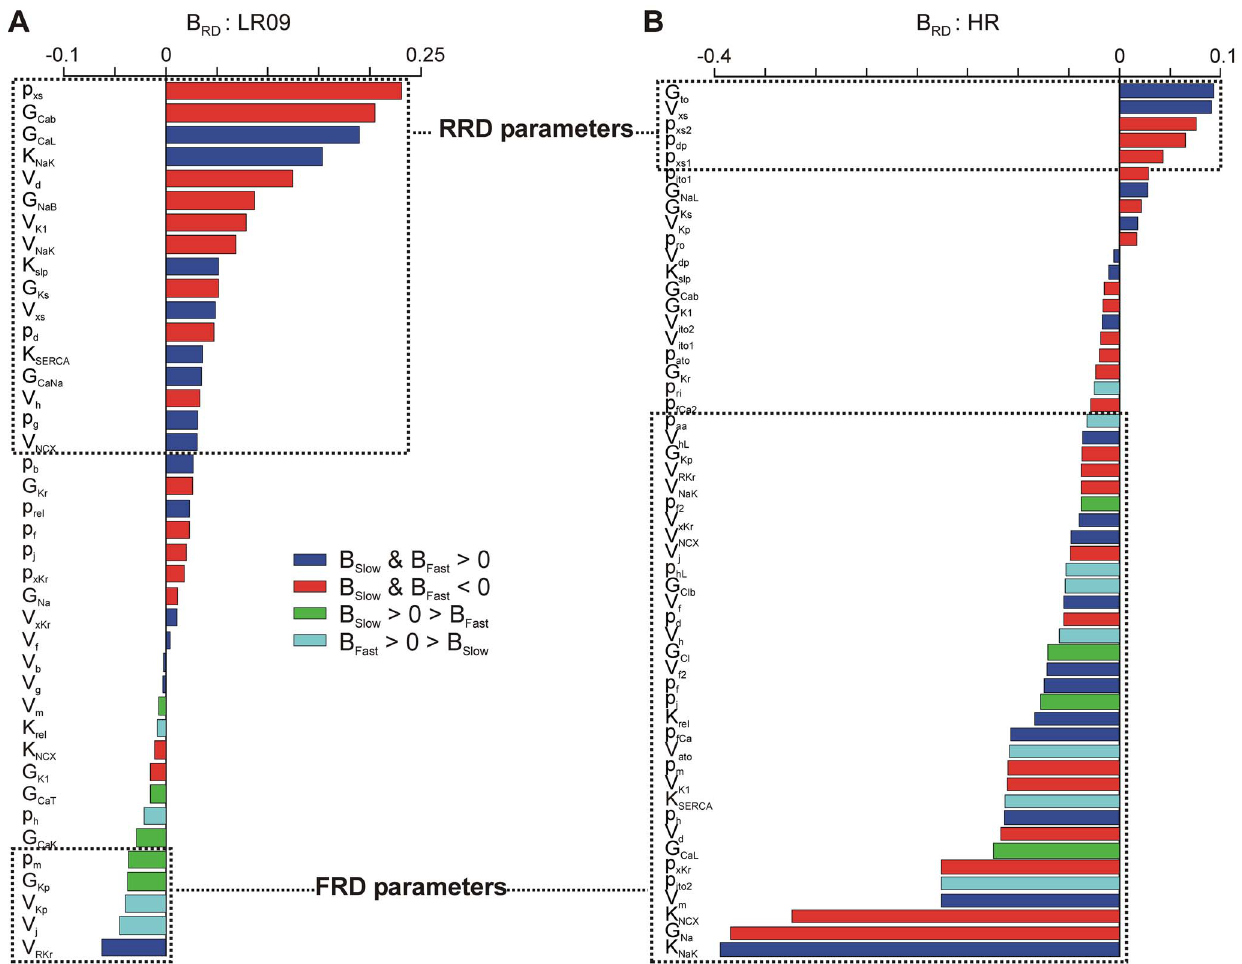
Figure 4. Inter-model comparison of APD parameter sensitivity rate dependence. Ventricular cell models were found to vary greatly in rate dependencies, which is apparent from variations in B RD plot structure. ( A ) B RD for the LR09 guinea pig model, showing largely RRD parameters. ( B ) B RD for the HR canine model, showing a majority of FRD parameters. B RD plots for all models studied can be found in Figures S1–S13 in Text S2. Figure 7. If a perturbation causes a large increase in an inward current, but exclusively at the slow rate, then this current would prolong the APD only at the slow rate, and contribute to reverse rate dependence. Thus by comparing the D Q at slow and fast rates, we can determine whether a particular current contributes to rate dependence.